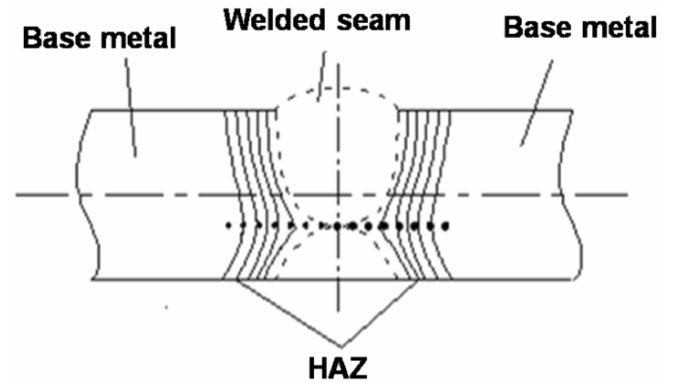
Figure 4. Position of micro-hardness measurement.